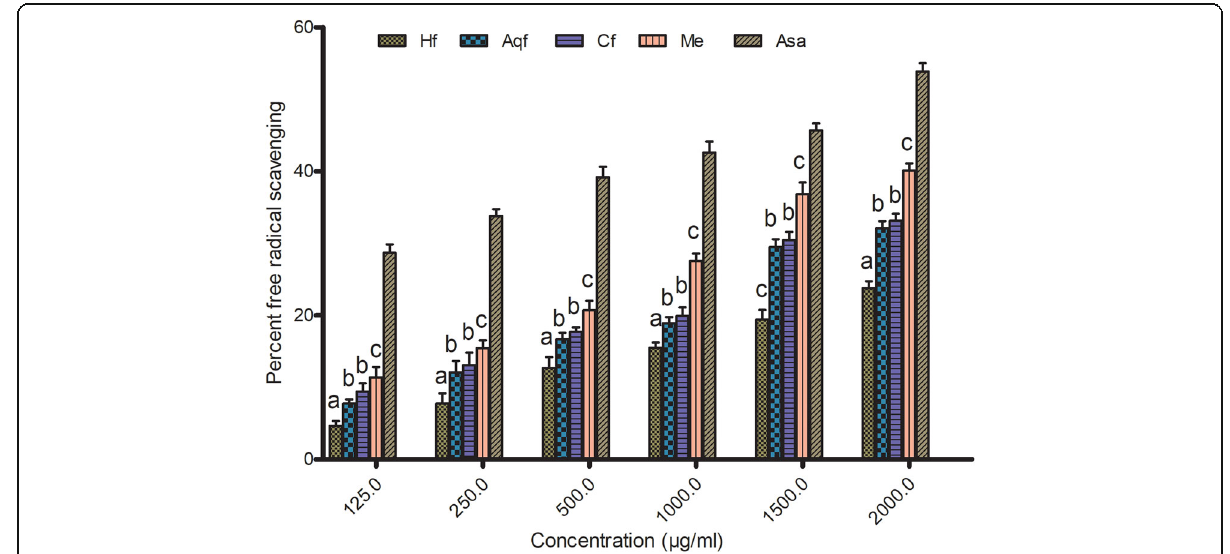
Fig. 1 DPPH free radical scavenging capability of the rhizome of Sorghum halepense (L.) Pers methanolic extract and its fractions. Aqf: aqueous fraction, Cf: chloroform fraction, Hf: n -hexane fraction and Me: methanolic extract Asa: ascorbic acid. The scavenging effect of extract and ascorbic acid was compared. c indicates significance at p <0.05, b at p <0.01 and a at p <0.001 (Dunnett ’ s-test). Performed the experiments in triplicate ( n